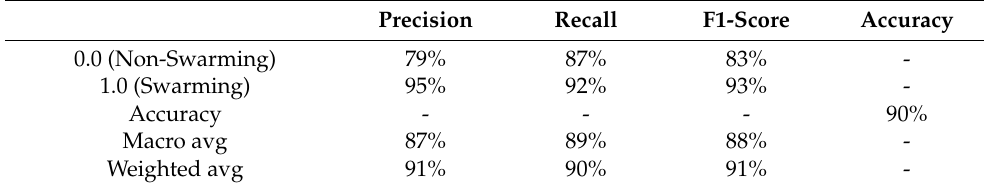
Table 7. SVM Classifier results applied ten days before the swarming event. Precision Recall F1-Score